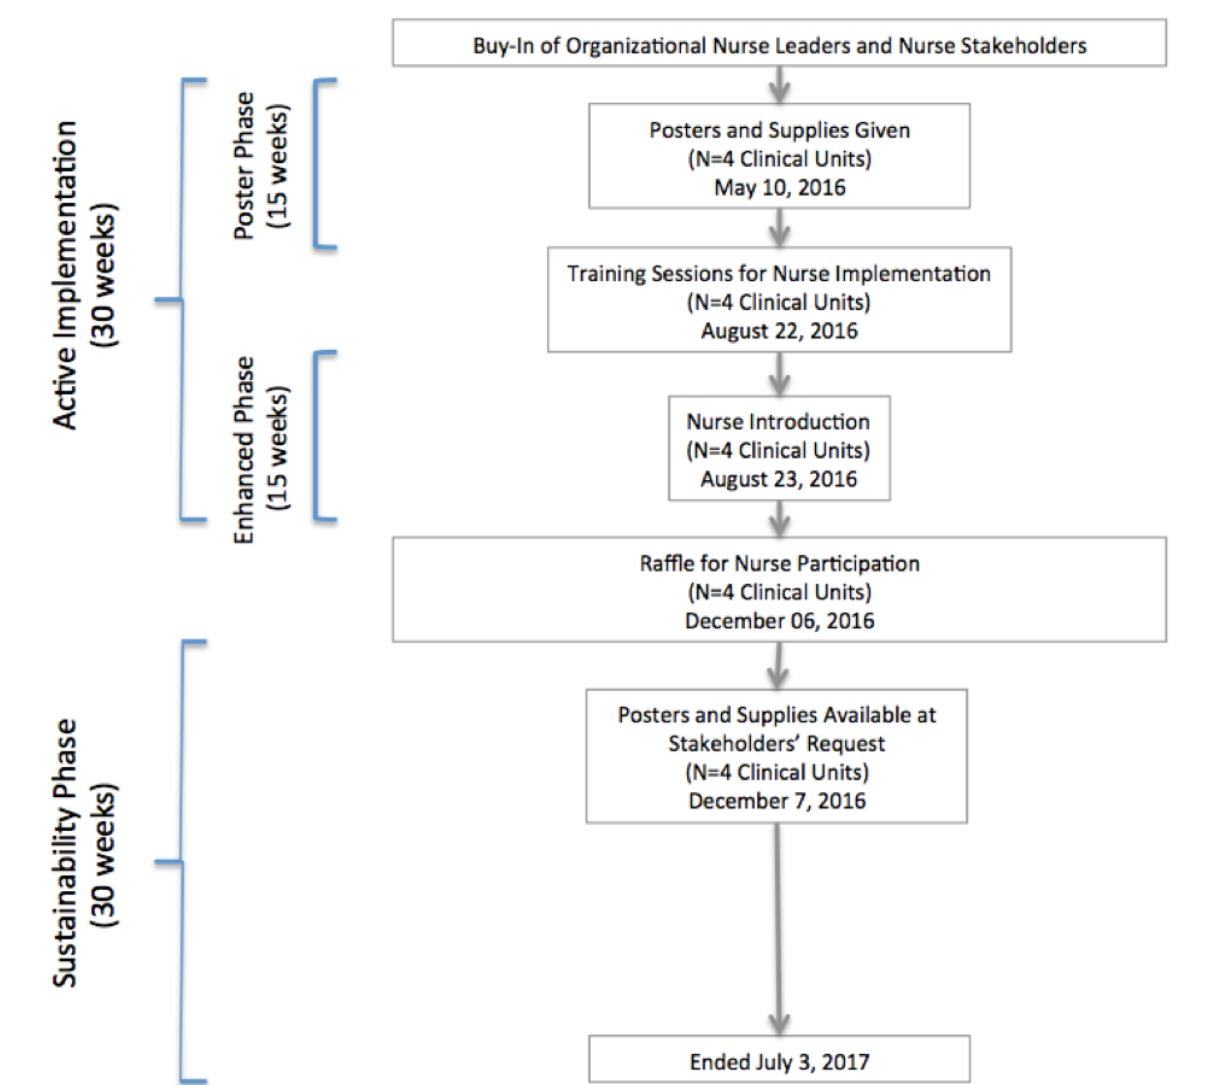
Figure 1. Study flow